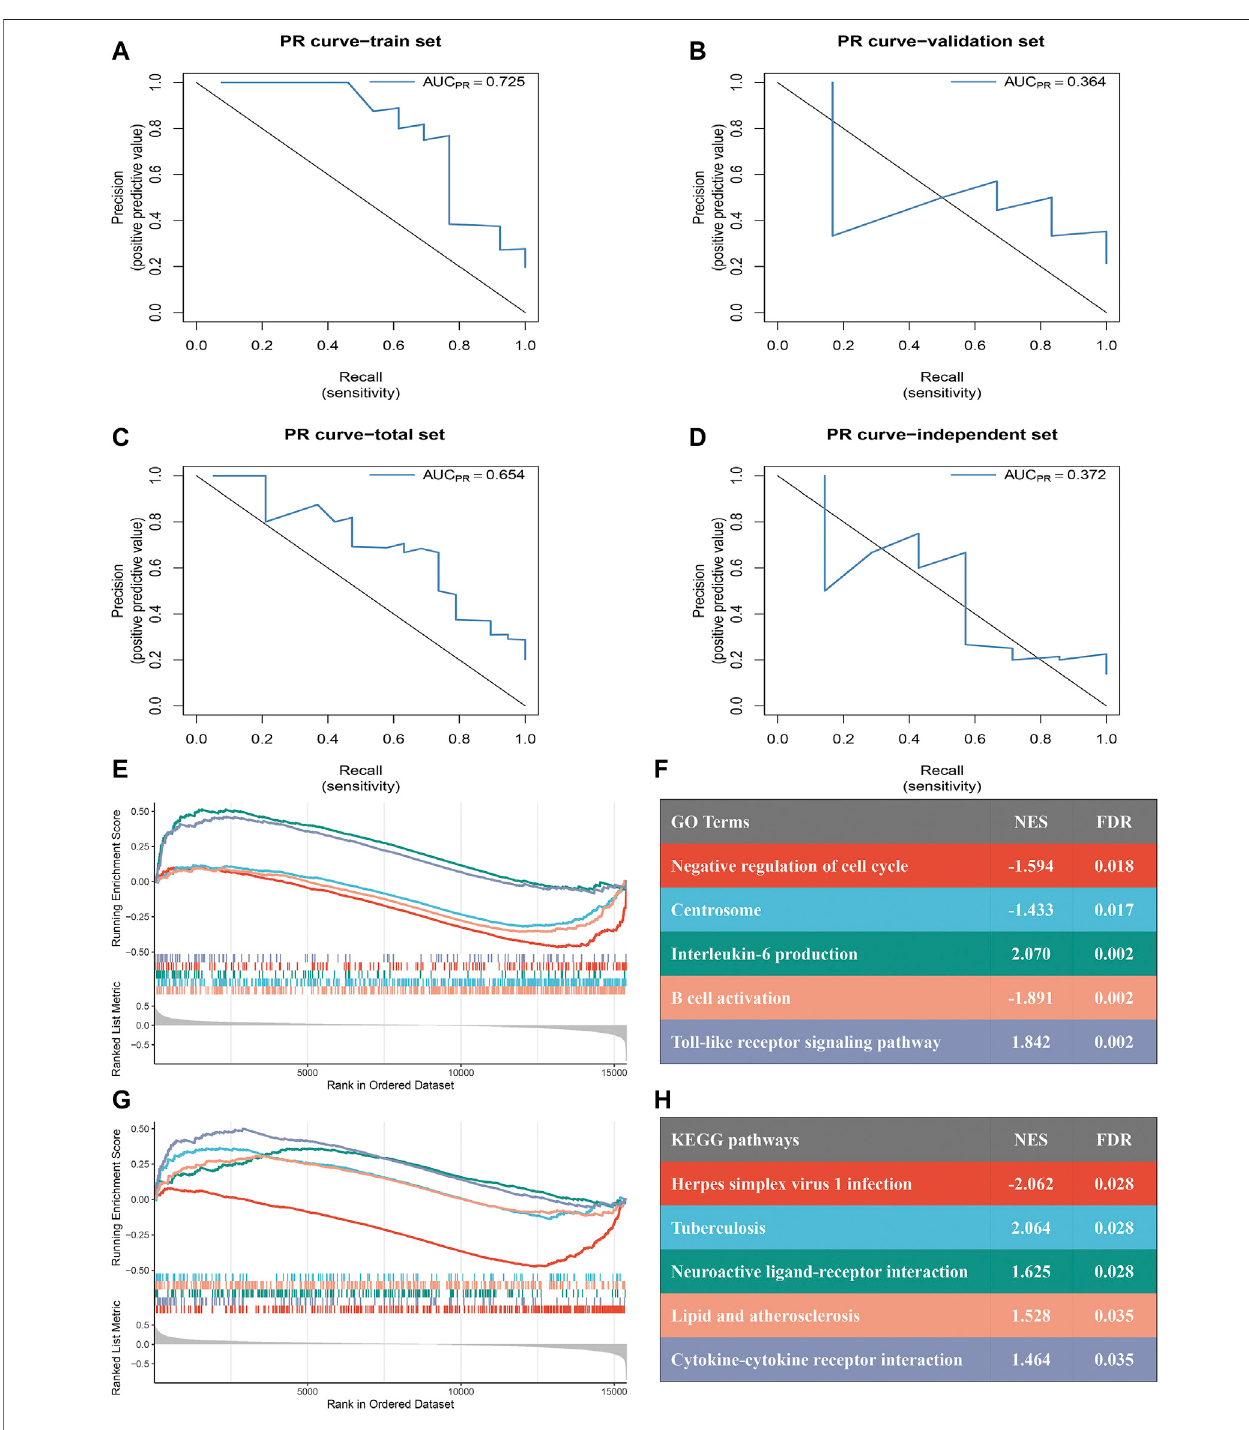
FIGURE 6 | PR curves assess the accuracy of the eight-gene model and GSEA of the two subtypes. (A – D) : PR curves were used to predict ischemic events after CEA in the train [ (A) : AUC = 0.725], validation [ (B) : AUC = 0.364], total [ (C) : AUC = 0.654] sets and independent cohort [ (D) : AUC = 0.372]. (E – F) : Top fi ve GO terms of differential genes in the high- and low-risk groups. (G,H) : Top fi ve KEGG pathways of differentially expressed genes in the high- and low-risk groups.